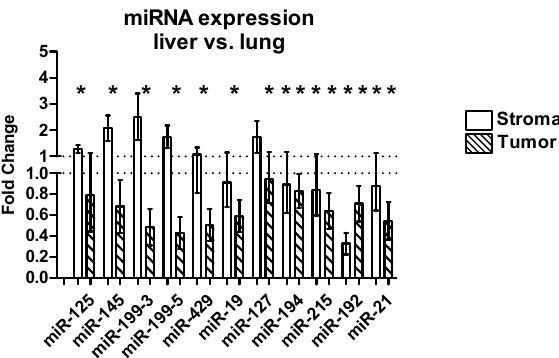
Figure 2. Differential expression between liver and lung metastases. The graph shows the mean fold change and the standard error of the mean SEM ( ΔΔ C t -Method) of the stromal tissue in the liver metastases compared to the stromal tissue in the lung metastases (empty bars) and the tumor tissue in the liver metastases compared to the tumor tissue in the lung metastases (hashed bars). p -values were calculated using the t -test. Significant expression differences are marked with an asterisk (*). Table 3. Differential expression of miRNAs in the tumor, the stroma, and the host tissue of liver and lung metastases (mean and standard error of the mean (SEM)). Positive values indicate upregulation; negative values indicate downregulation. p -values were calculated using the t -test. FC: fold